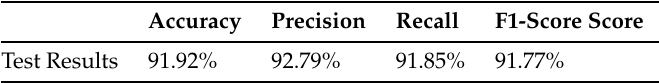
Table 15. Evaluation results of the model trained by CNN network.